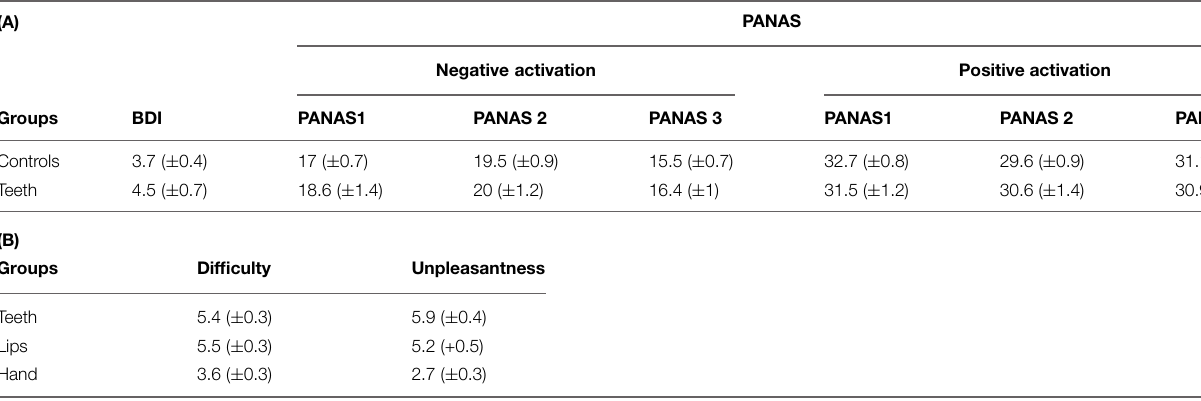
filled in PANAS 2. On day 2, participants performed a drawing task during which memory of the text was reactivated while facial feedback was manipulated. Two minutes after the drawing task, participants realized a second emotional evaluation and memory evaluation of the text and filled in PANAS 3.